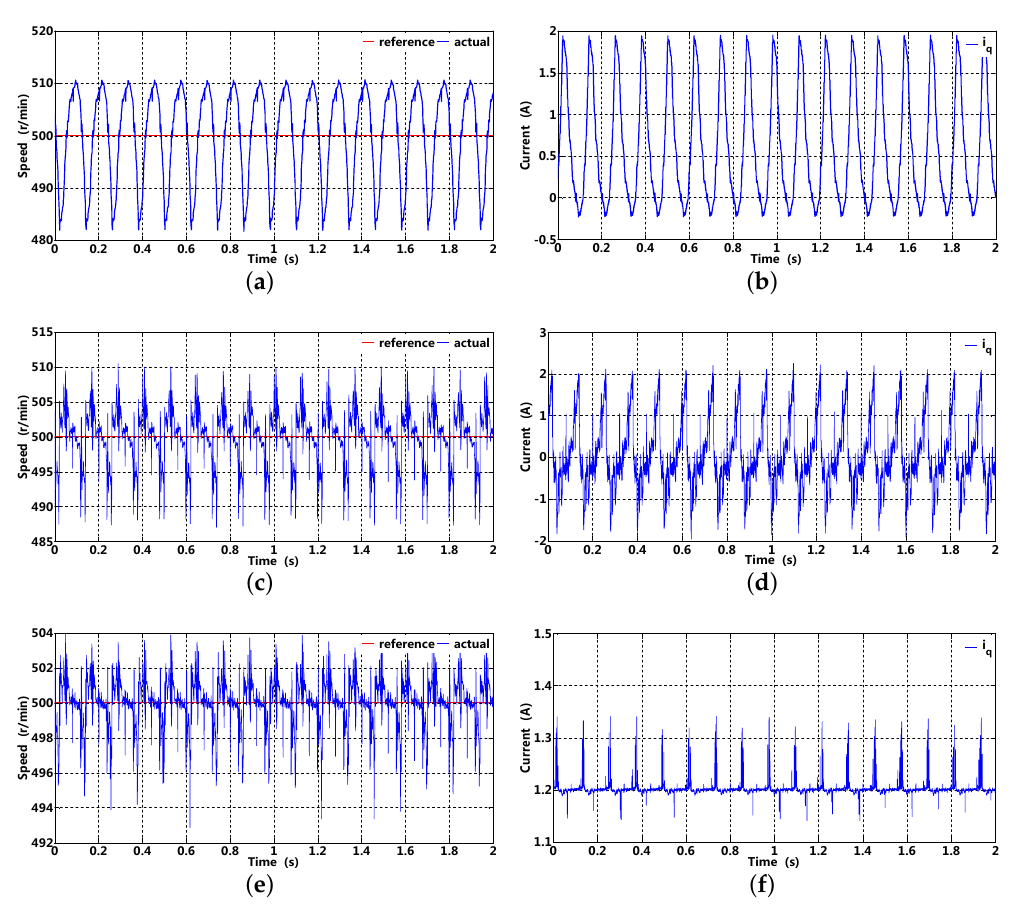
Figure 21. Speed and corresponding q -axis current based on original PI controller (without q -axis current compensation), DOB and ARRC (25 Hz). ( a , b ) speed and corresponding q -axis current with original PI controller; ( c , d ) speed and corresponding q -axis current with DOB; ( e , f ) speed and corresponding q -axis current with